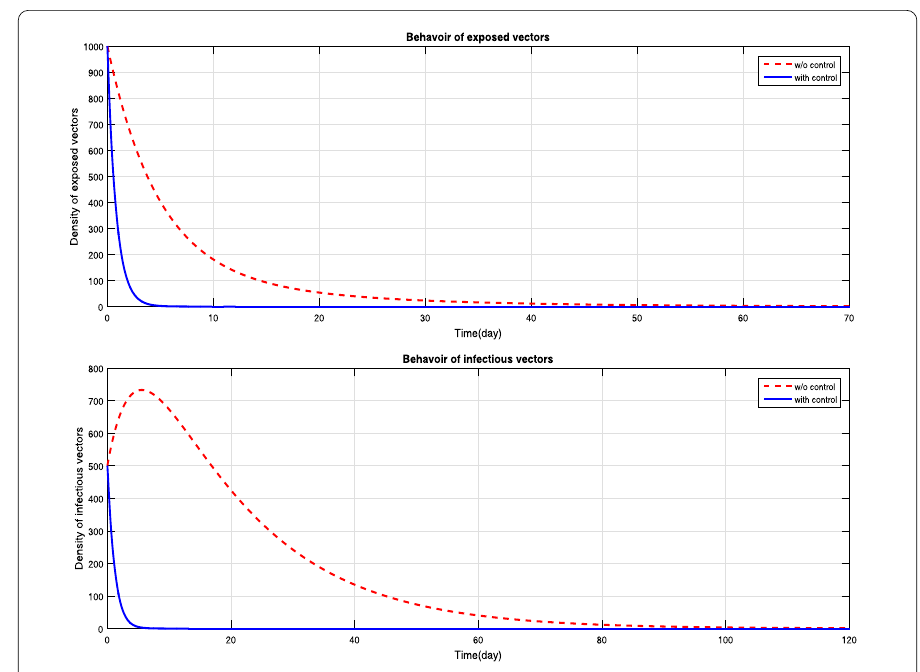
Figure 12 Comparison of behaviors with and without control in case of E v and I v